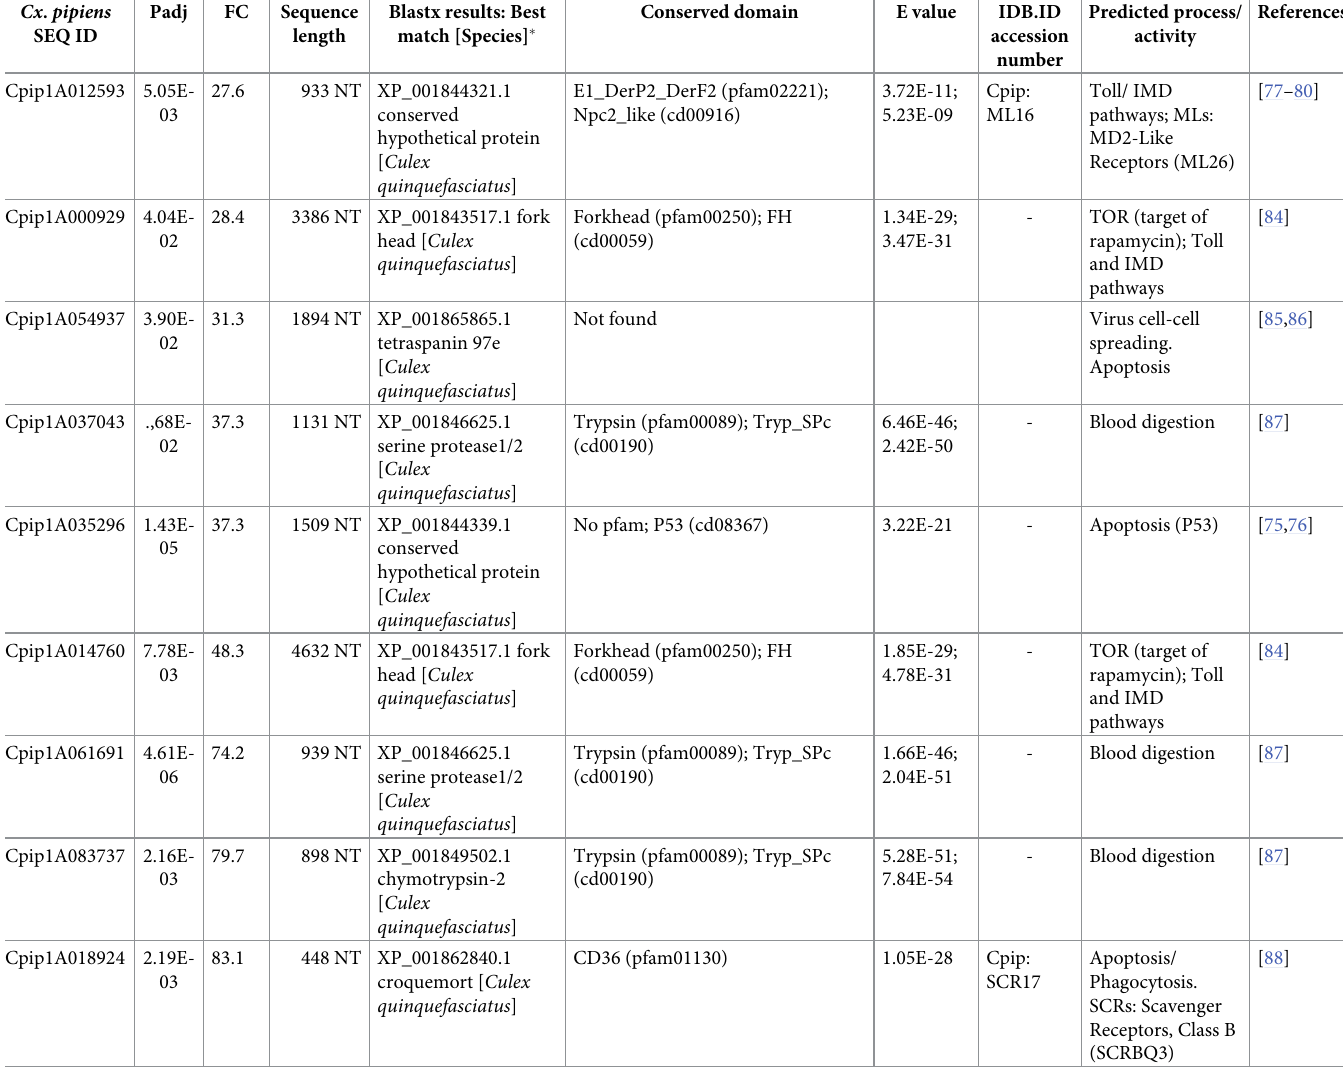
(Cpip1A019555) and the nuclear pore complex protein Nup88-like (Cpip1A005797) related to antiviral/immune response process in insects. Evolution of the immune response upon RVFV exposure in Culex pipiens mosquitoes All of the above detailed DEG during RVFV-exposed in mosquitoes were involved in the con- ventional immune Toll/IMD pathways, RNAi mechanism, the ubiquitination pathway, apo- ptosis and other inducible antiviral immune genes (Fig 3). Most of the transcriptional changes related to immunity occurred at the early RVFV-infection stage (2 hpe) in all the